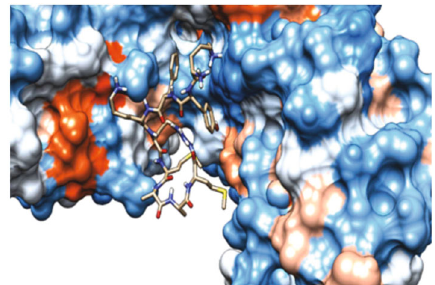
Figure 13: Illustration of the 3D interaction of the best docking poses of KYFKRMAAM in the binding sites of HLA-A ∗ 02:06.